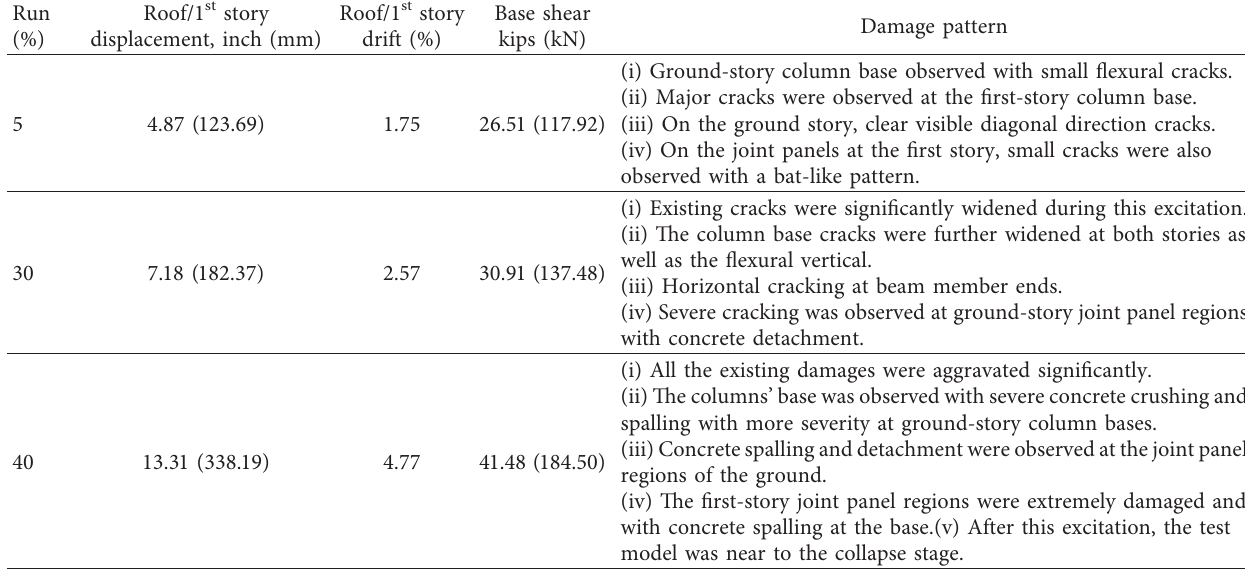
Table 1: Observed response and damage condition of Model-1 under significant